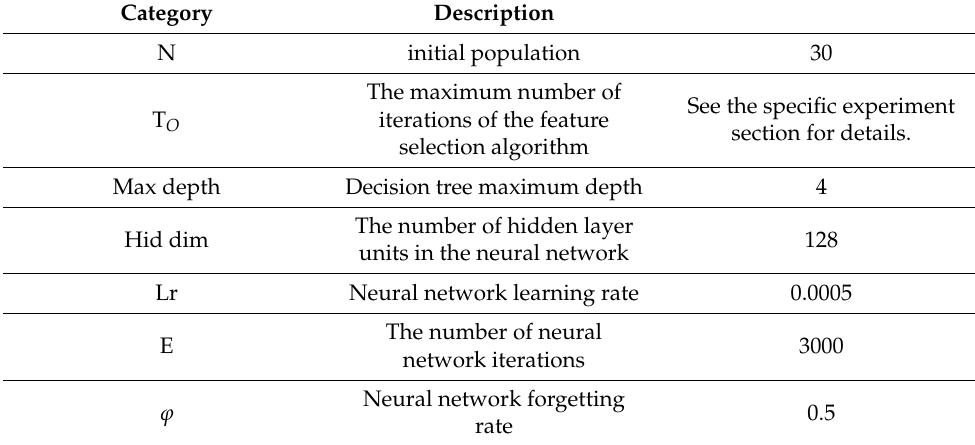
Table 5. Detailed experimental